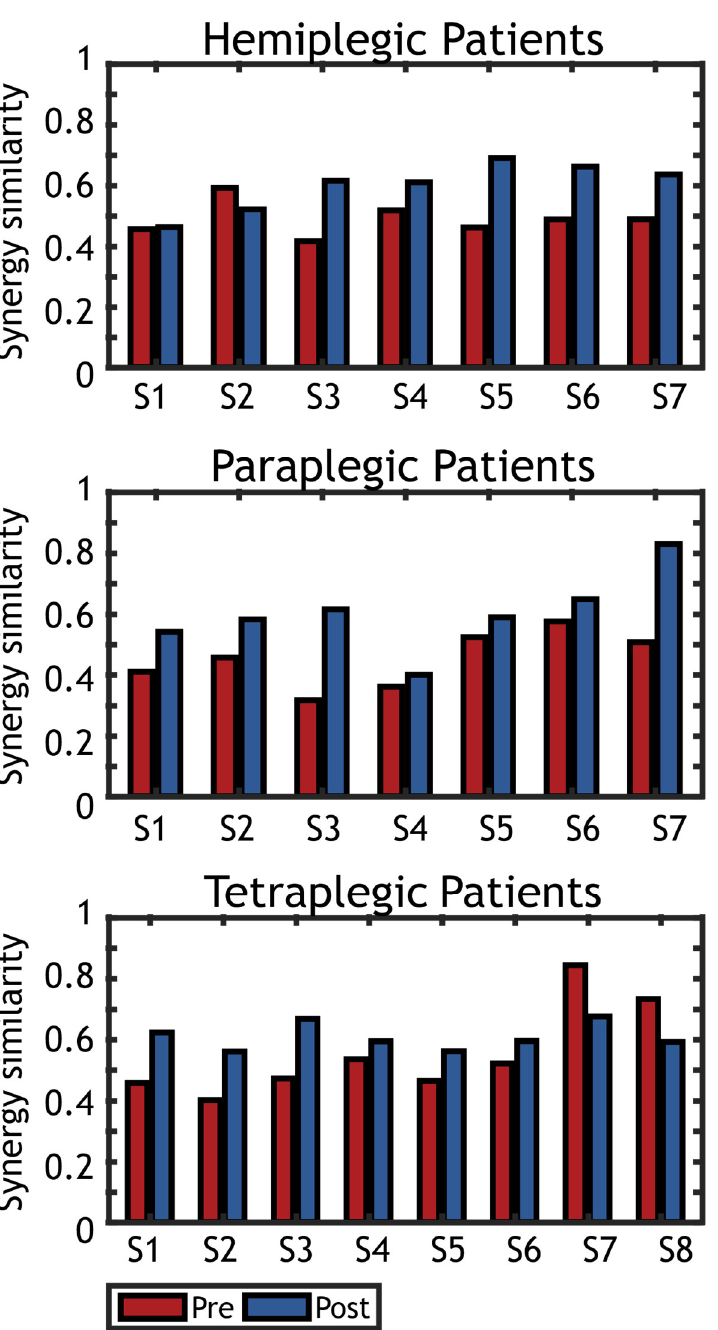
Figure 6. Spatial synergy similarity (healthy vs. tetraplegic) before (Pre) and after (Post) treatment. Graphs represent the similarity of the synergies extracted on each patient with the reference dataset of spatial synergies found on healthy controls. Pre-tratment synergy similarity is represented in red, while post-treatment synergy similarity is represented in blue.